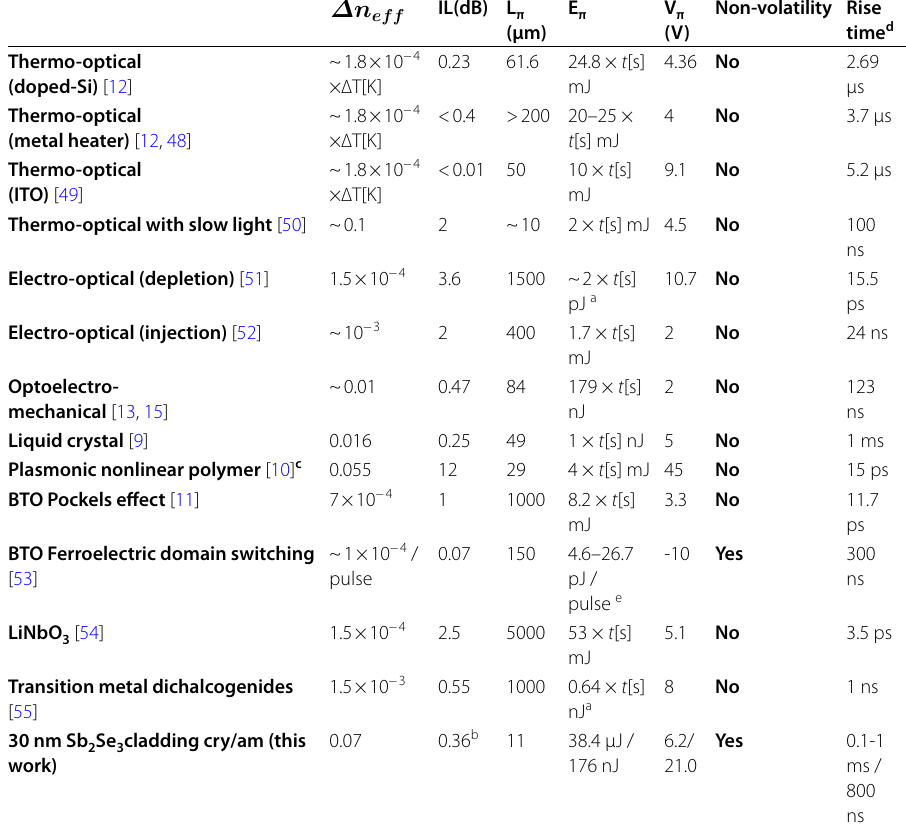
Table 1 Comparison of phase shifter platforms currently available in 220 nm SOI at 1550 nm. E the energy required to switch and hold the state. ∆T is the difference in temperature, and t[s] is the time of operation ∆n